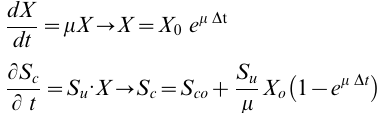
Table S1 Metabolic reconstruction for central metabolism in cancer.